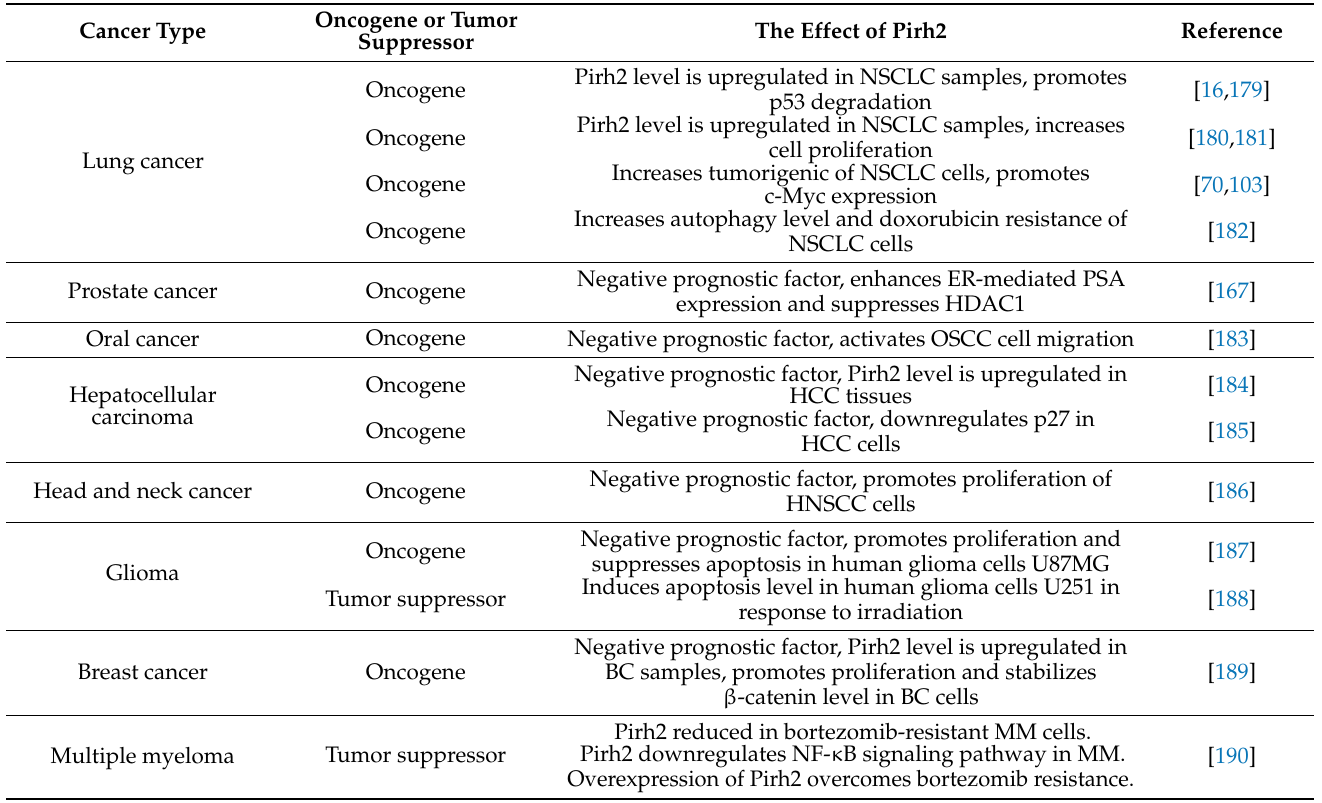
Table 2. The role of Pirh2 in different cancer